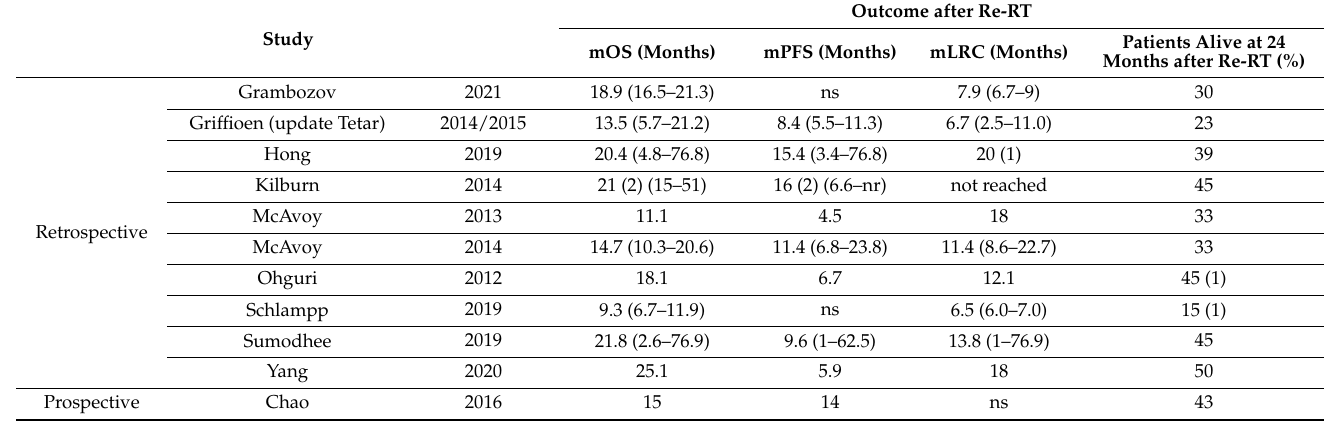
Table 3. Clinical outcome after re-irradiation (ns = not stated, nr = not reached). The outcome numbers in brackets and square brackets refer to crude ranges and 95% confidence intervals, respectively.